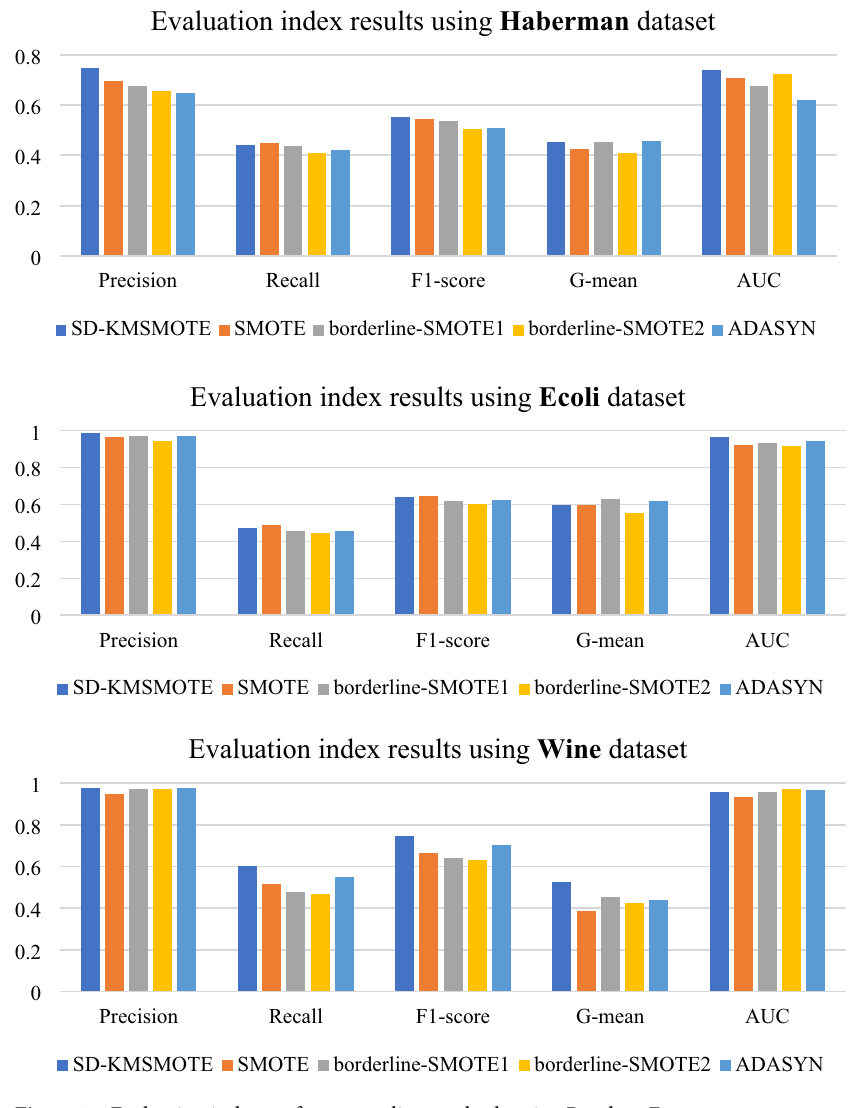
Figure 7. Evaluation indexes of oversampling methods using Random